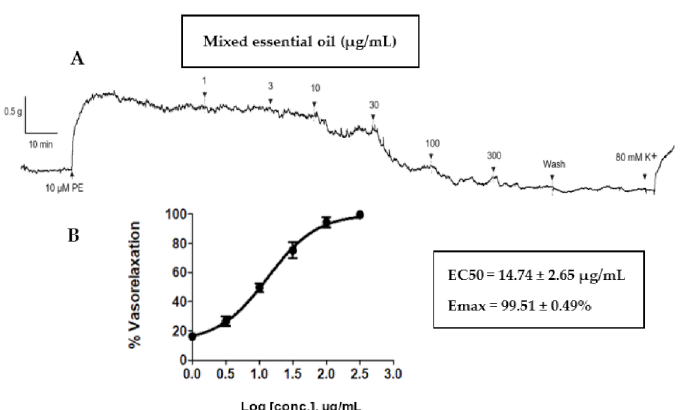
Figure 5. ( A ) A typical trace of the vasorelaxant effect of the mixed oil distilled from the herbal com- press mixed ingredients (0–300 µ g/mL) on endothelium-intact aortae. ( B ) Concentration-relaxation curves for mixed oil from anti-cellulite herbal compress (1–300 µ g/mL) on endothelium-intact aortic rings. All data points are means ± SEMs ( n = 5).